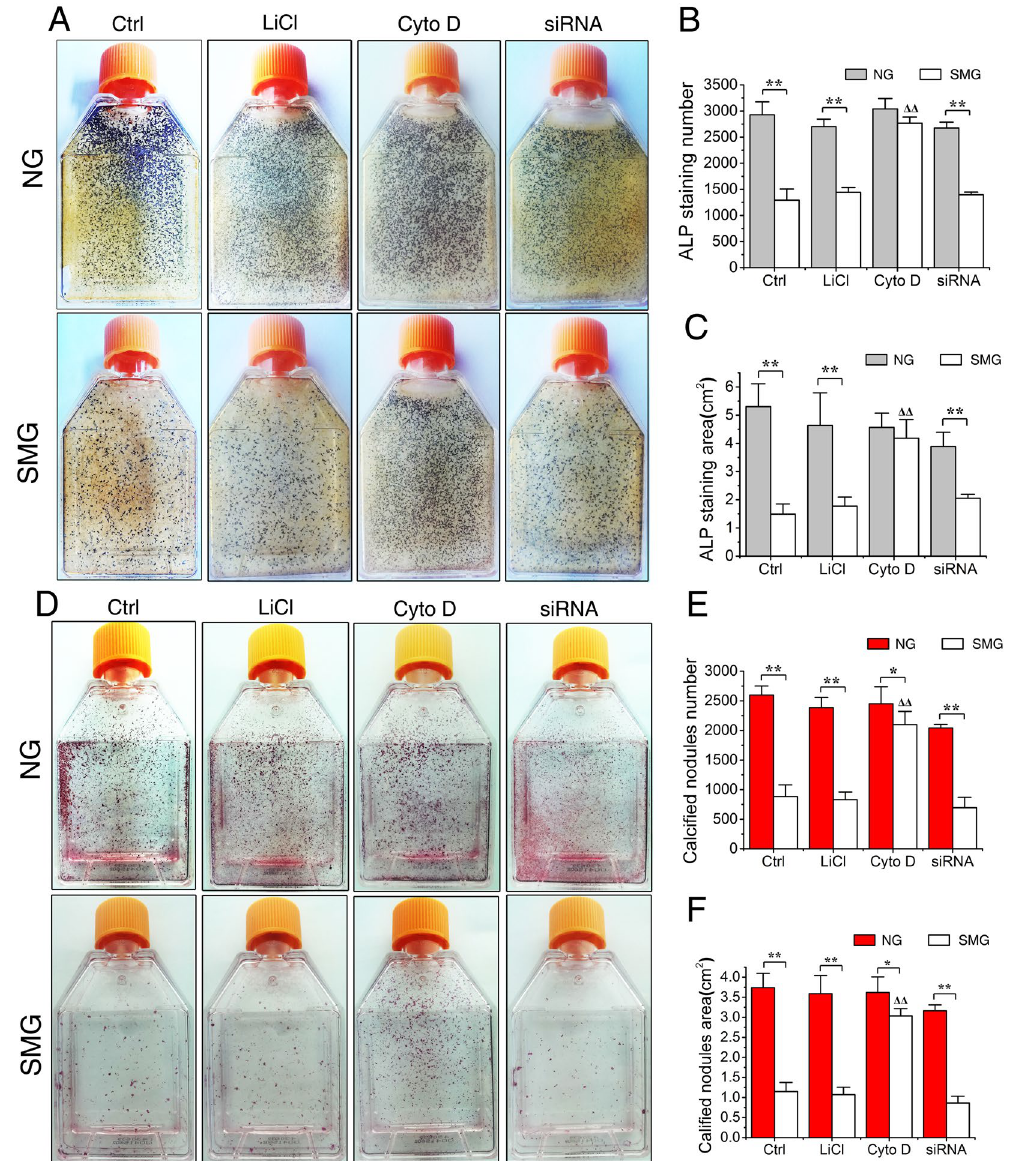
Figure 7. Elongation of cilia promotes the maturation and mineralization of rat calvarial osteoblasts (ROBs) in microgravity condition. ( A ) Representative images of alkaline phosphatase (ALP) stained CFU-F ALP colonies after 8 days in Ctrl group, LiCl group, cytochalasin D (Cyto D) group or dynein light chain Tctex-type 1 (Dynlt1) siRNA group with or without random positioning machine (RPM) microgravity exposure. ( B and C ) The numbers and areas of CFU-F ALP in each group. ( D ) Representative image of stained mineralized nodules after 12 days in each group. ( E and F ) The numbers and areas of mineralized nodules in each group. NG: normal ground, SMG: simulated microgravity. Each experiment was conducted at least three times independently. * P < 0.05 or ** P < 0.01 vs NG group of each treatment; △△ P < 0.01 vs Ctrl of SMG